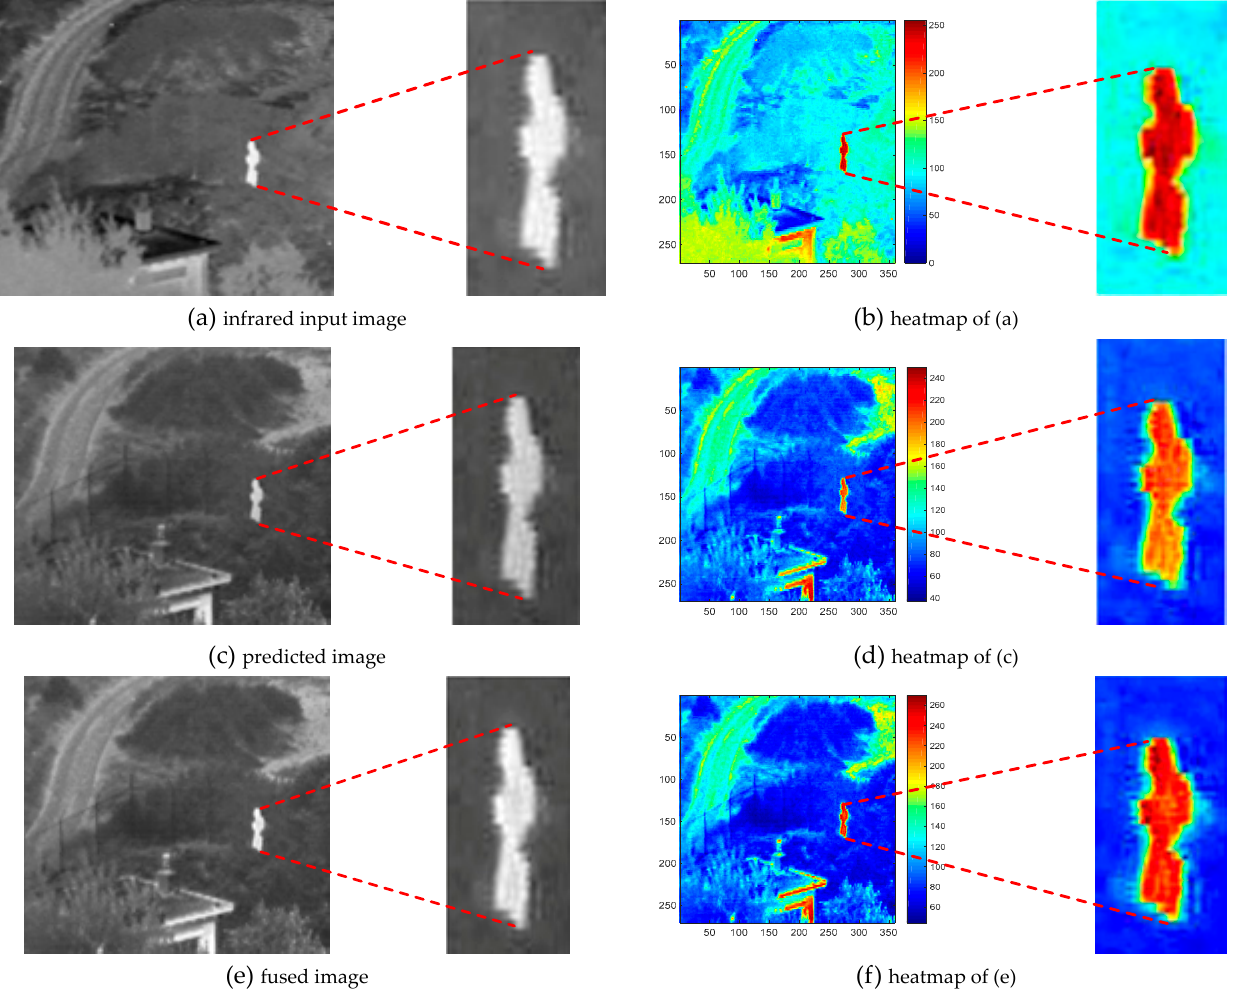
Figure 2. Infrared input image, predicted image, fused image, and their corresponding heatmaps.